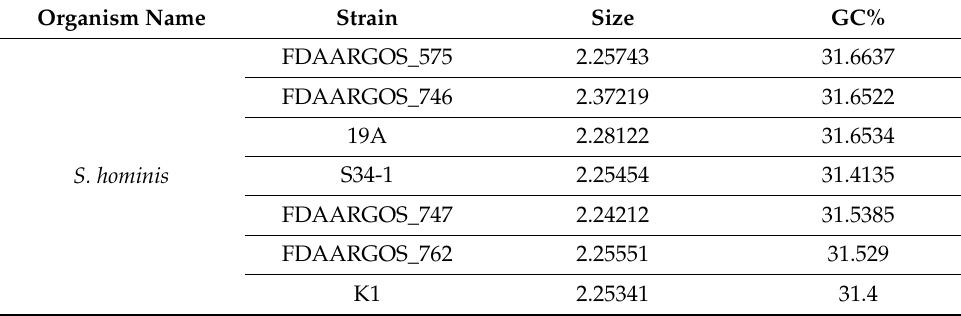
Table 1. Bacterial strains used in the process.